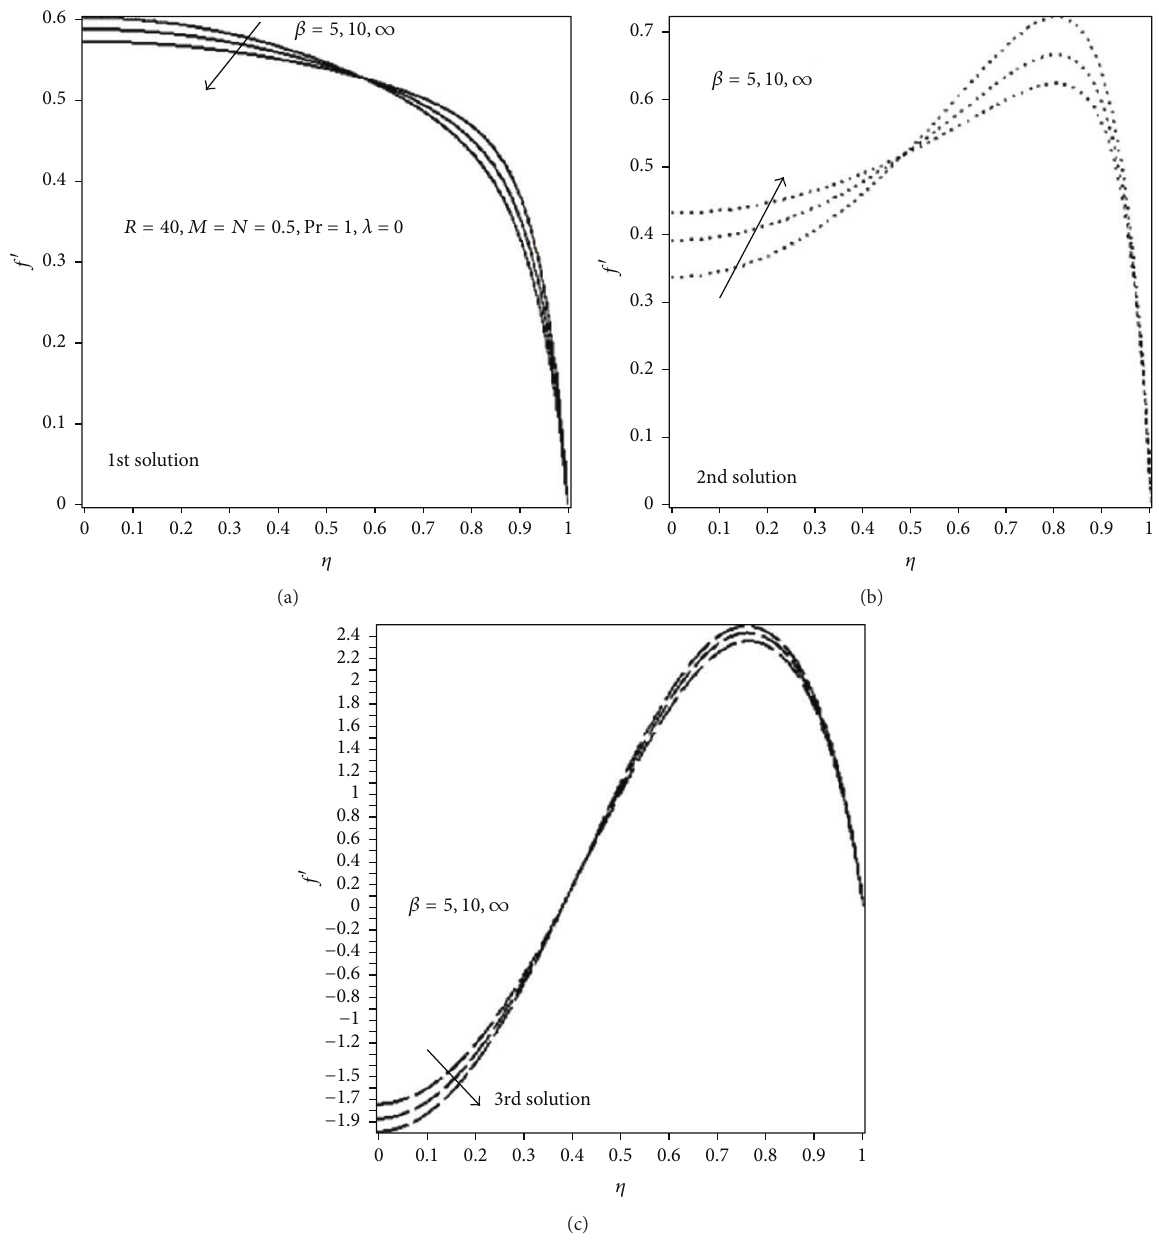
Figure 4: Effect of Casson parameter 𝛽 on velocity profile 𝑓 󸀠 (𝜂)